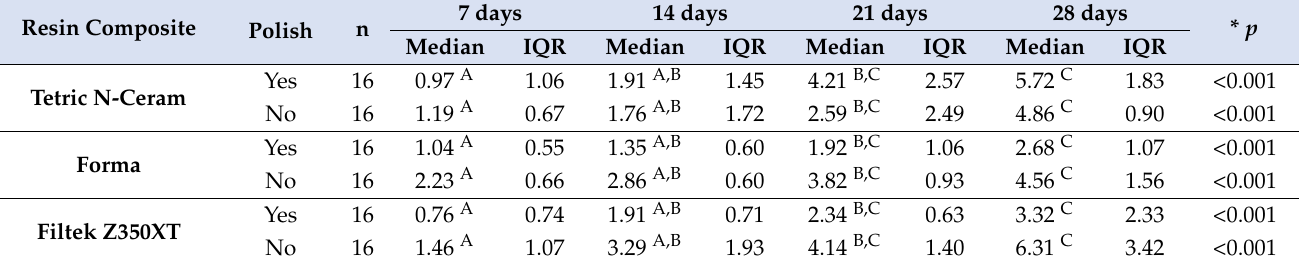
Table 5. Color variation ( ∆ E) comparison over time according to the type of resin composite with and without polishing.